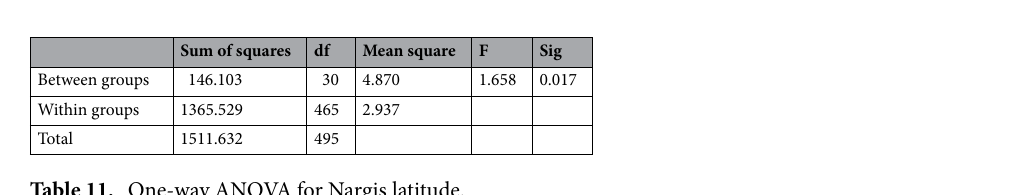
Table 11. One-way ANOVA for Nargis latitude.